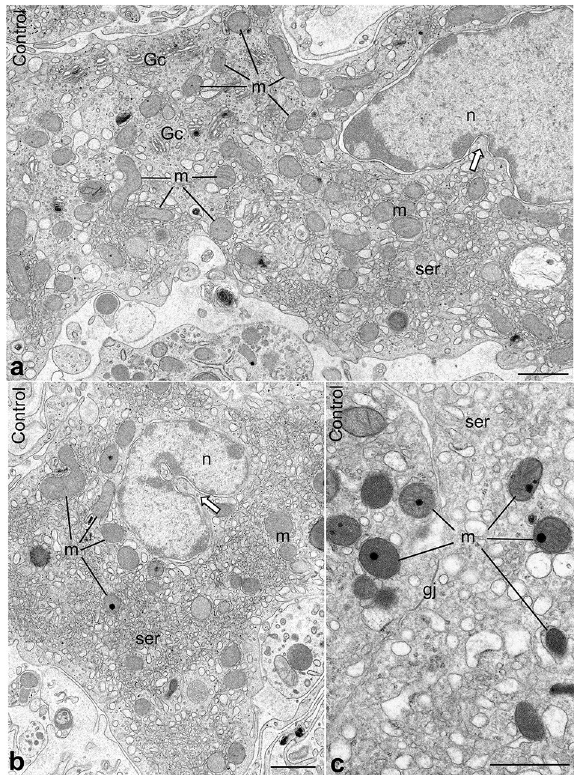
Figure 2. Ultrastructure of Leydig cells from control animals. ( a , b ) Random sections through the central (containing nucleus) cell region. Note relatively small, predominantly spherical mitochondria (m), SER elements (ser), Golgi complexes (Gc) and cell nucleus (n). Thick white arrows indicate infoldings of the nuclear envelope. ( c ) Gap junction (gj) between two adjacent Leydig cells. Bars represent 1